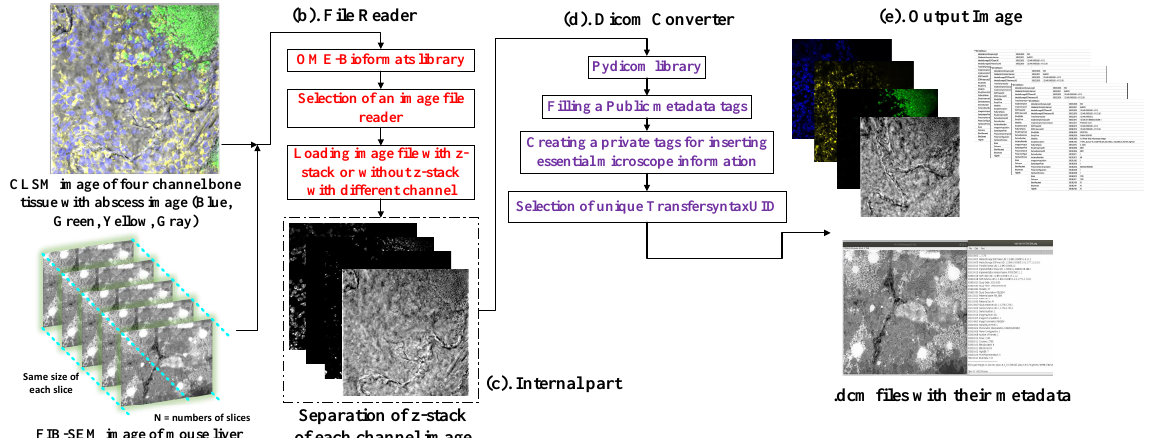
Figure 4. Pipeline for the conversion of CLSM and FIB-SEM microscope imaging modalities into standard